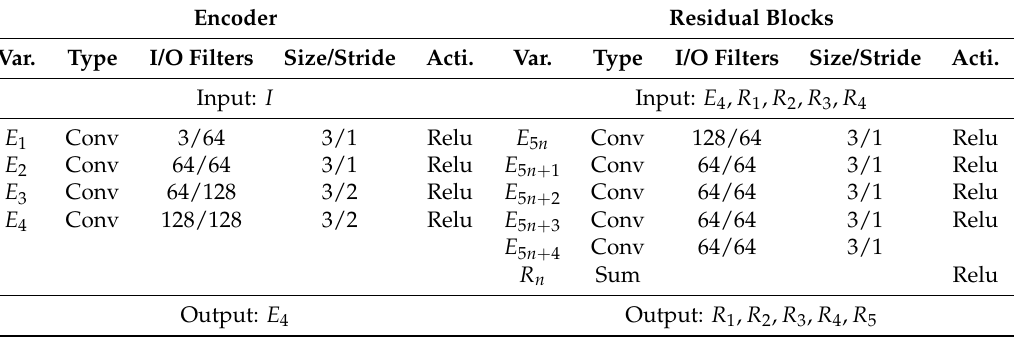
Table 1. Details of encoder and residual blocks.